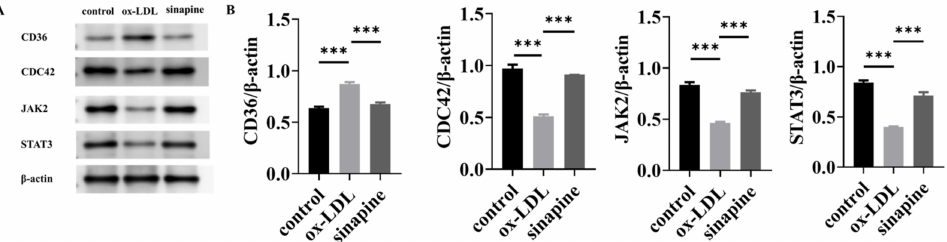
Figure 6. Expression and validation of key proteins after sinapine treatment in foam cells. ( A ) Effects of sinapine on protein levels of CD36, CDC42, JAK2, and STAT3 determined by Western blotting. ( B ) Relative protein content of CD36, CDC42, JAK2, and STAT3 protein expressions was calculated by grayscale analysis with ImageJ. Note: *** p <